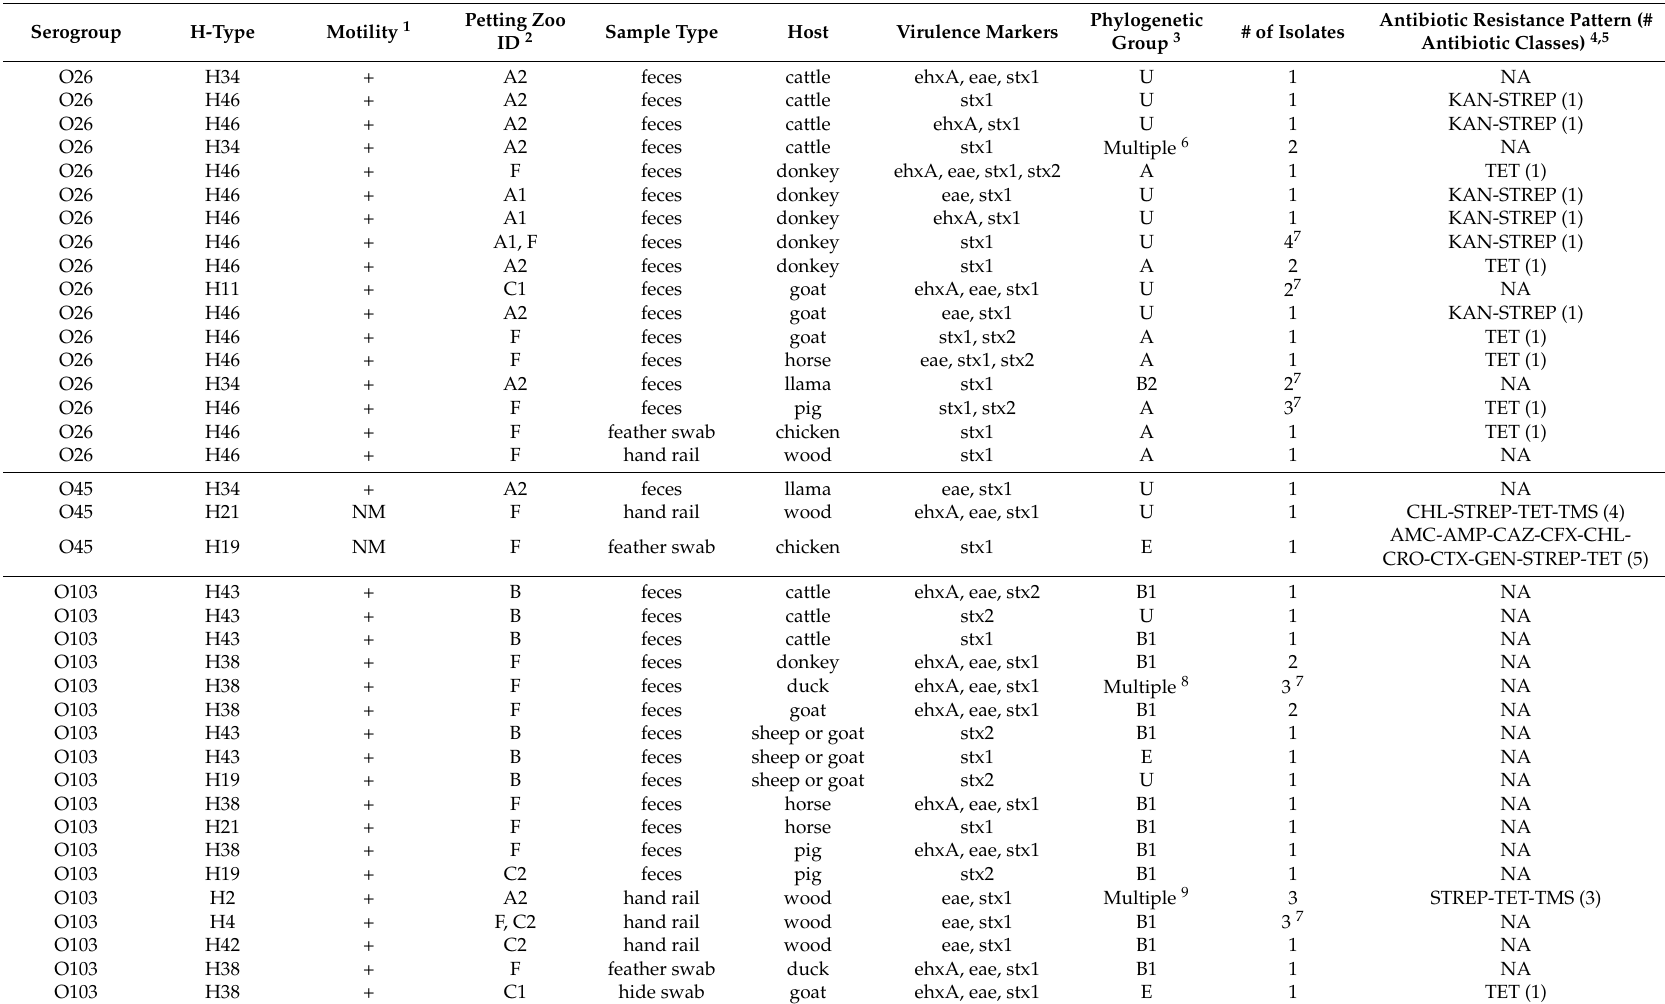
Table 3. Characteristics of STEC isolates ( n =